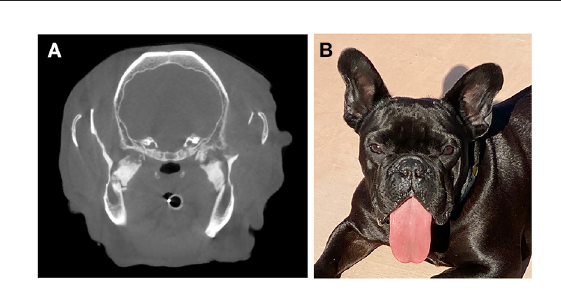
FIGURE4 The dog described in Case 1 at its 3-year recheck exam. (A) Note the relatively static appearance of the lesion as demonstrated on the CT image as comparted to Figure 1. (B) Clinical image demonstrating the visual appearance 3 years following